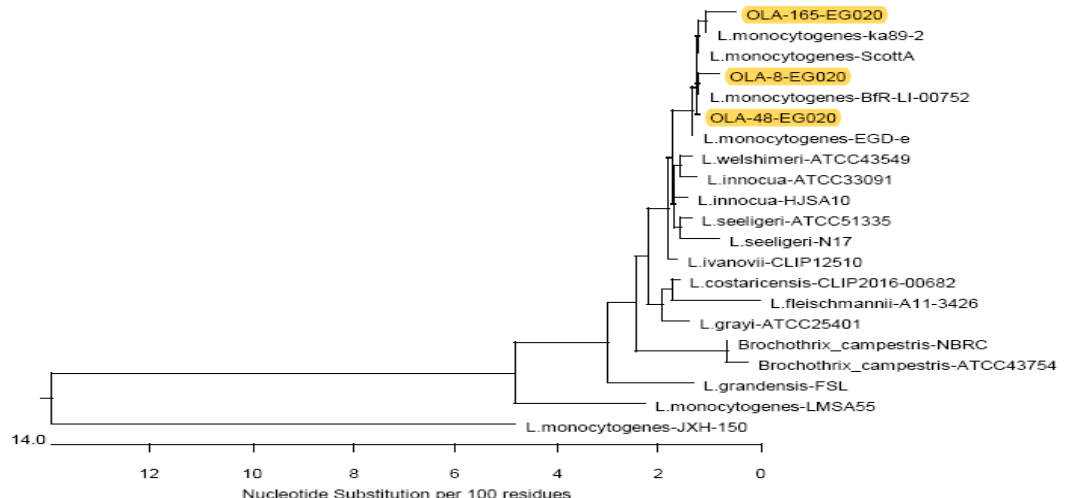
Figure 5. Neighbor-joining phylogenetic tree of Listeria monocytogenes from raw milk, fish fillet and minced meat based on the partial 16S rRNA gene sequences. Sequences (highlighted in yellow color) from raw milk (OLA-165-EG020, accession number MW090064), fish fillet (OLA-8-EG020, accession number MW090062) and minced meat (OLA-48-EG020, accession number MW090063) were generated in this study.